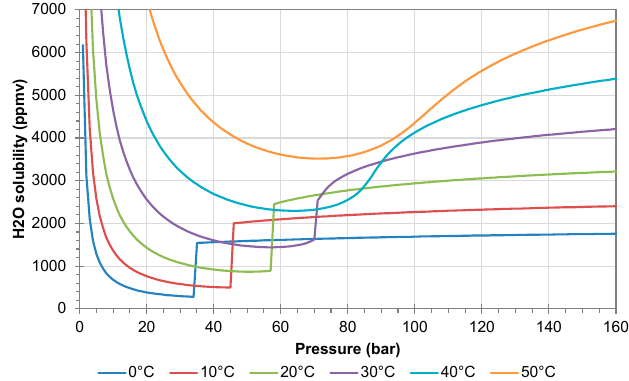
Figure 1. Water solubility (ppmv) in CO 2 as a function of pressure and temperature. The data were calculated with the OLI software.